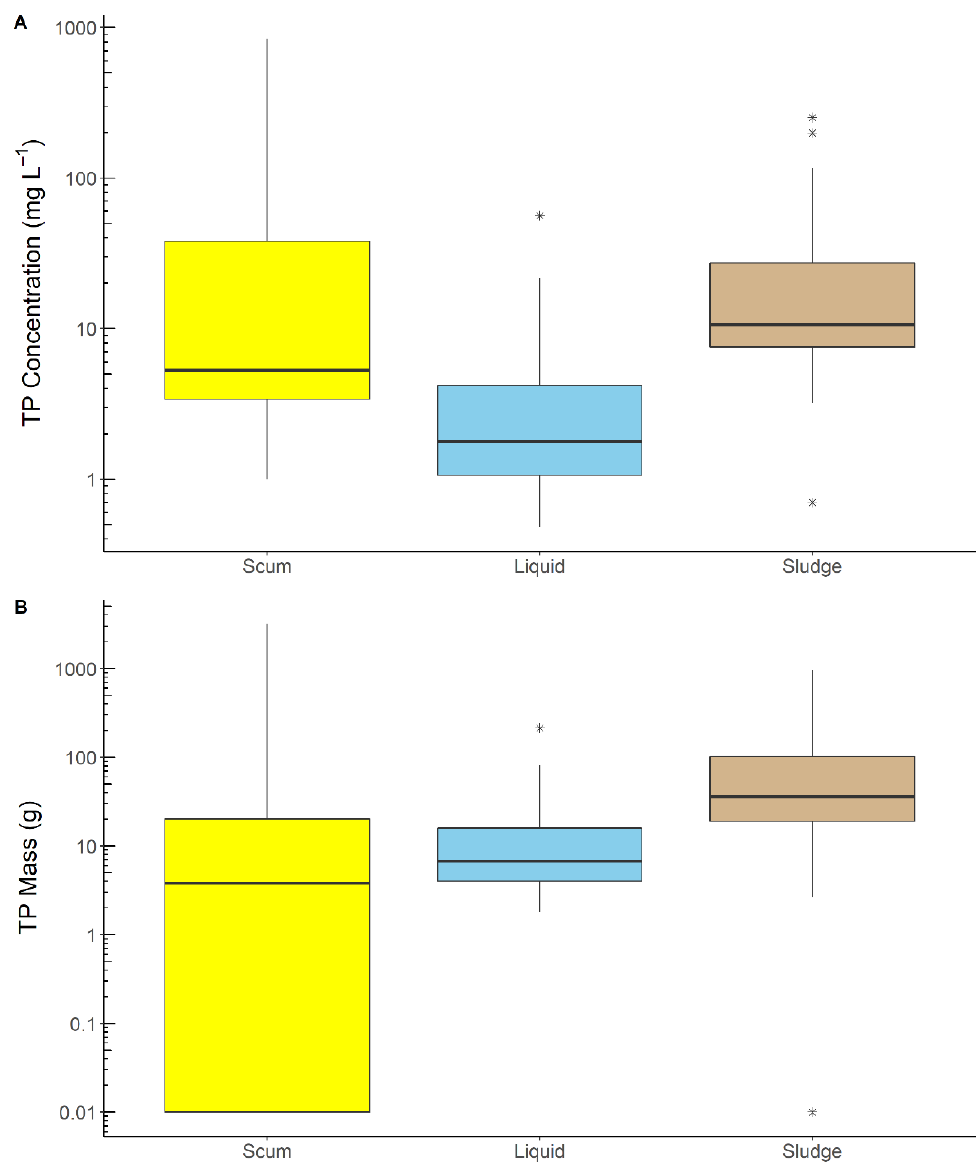
Figure 3. Boxplots of total phosphorus (TP) concentrations ( A ) and masses ( B ) for scum, liquid, and sludge layers from septic tanks. Mass values of “0 g” were coded as “0.01 g” to represent values that were below detection or layers that were absent at time of sampling. Asterisks (*) represent